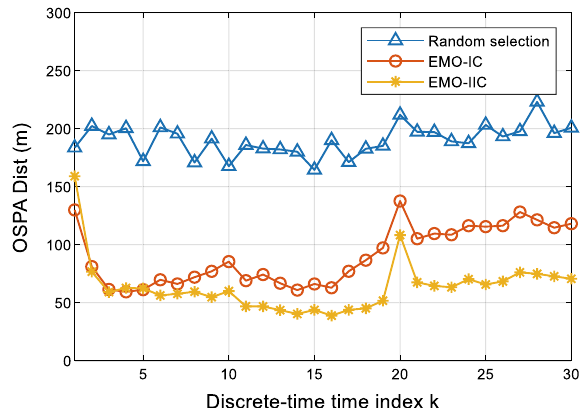
Fig. 6 Average OSPA distances in Experiment